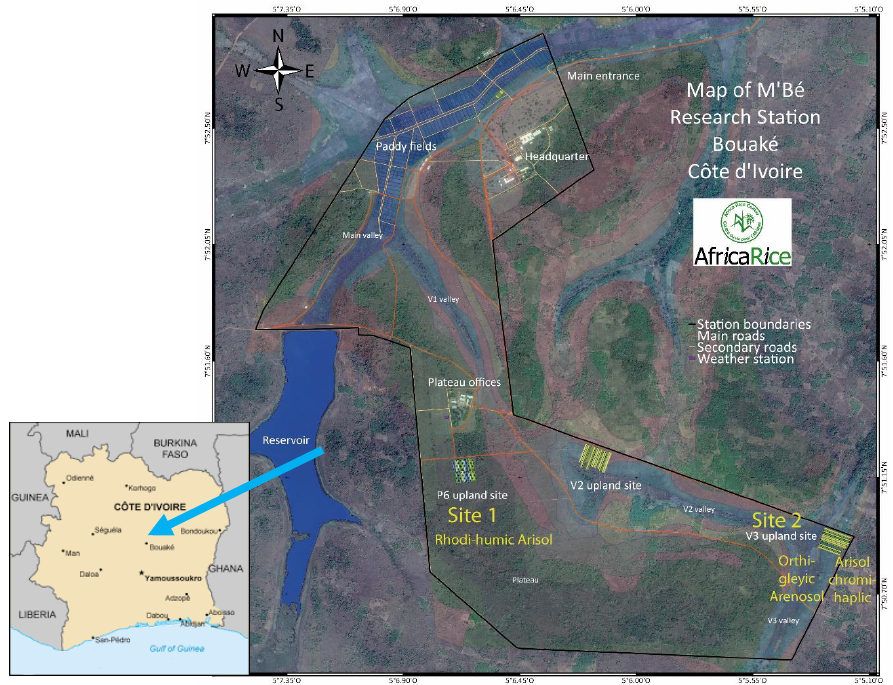
Figure 1. Location of the experimental site.